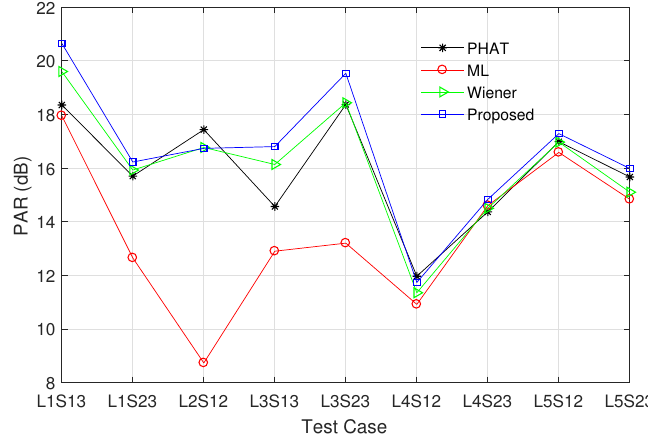
Figure 12. PAR of various prefilters in field measurements, when α = 0.45, N = 4096, and M =